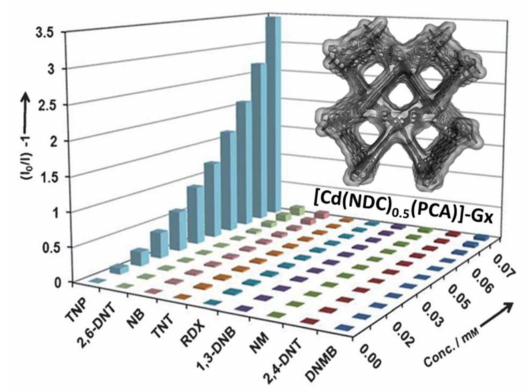
Figure 18. Quenching efficiencies of tested nitro-explosives at different concentrations on the fluores- cence of [Cd(NDC) 0.5 (PCA)]-Gx at room temperature; inset: the structure of [Cd(NDC) 0.5 (PCA)]-Gx. Adapted from